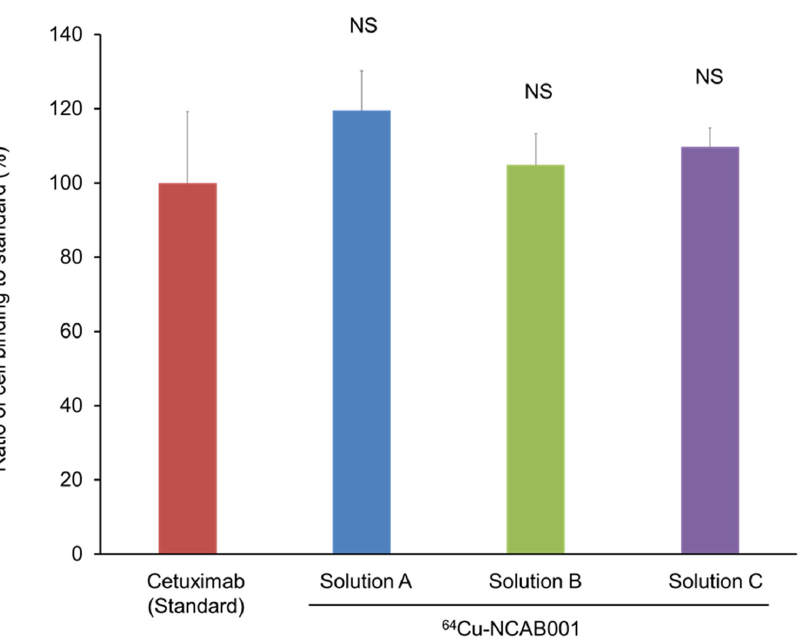
Figure 4. Effect of the stock solutions on the cell-binding properties of 64 Cu-NCAB001. PCTA- NCAB001 that was dissolved in Solutions A, B, and C (compositions in Table 1) and stored at 4 °C for 12 months was labeled with 64 Cu. The binding properties to HCT116 cells were evaluated using cetuximab as the reference standard. NS = Not significant vs. standard.